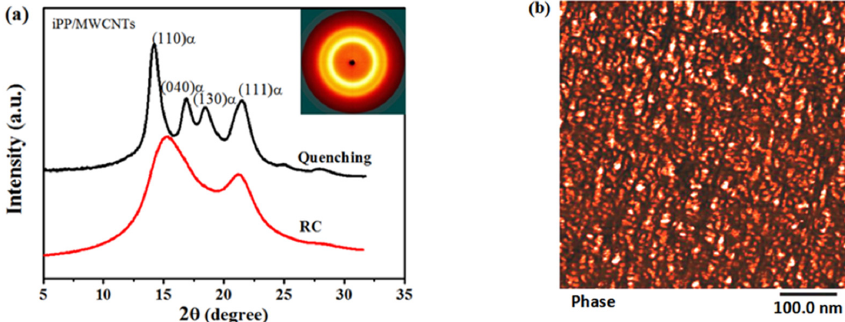
Figure 2. ( a ) Selected 1D WAXD profiles of the RC and quenching composites with the inset of 2D-WAXD pattern of RC sample; ( b ) AFM image of RC samples.